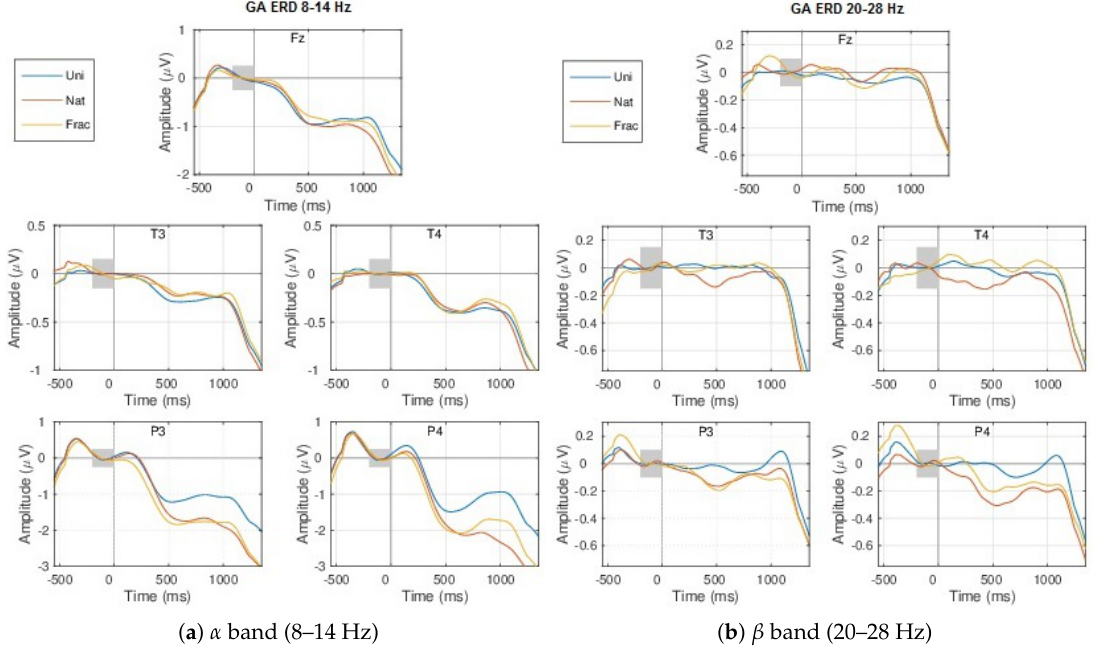
Figure 7. GA ERDs over all blocks, for the 3 types of images: Uni (blue), Nat (red), Frac (orange), considering all channels and the: ( a ) α (8–14 Hz) and ( b ) β (20–28 Hz) frequency bands. The shaded grey area marks the considered baseline period ( − 200,0)